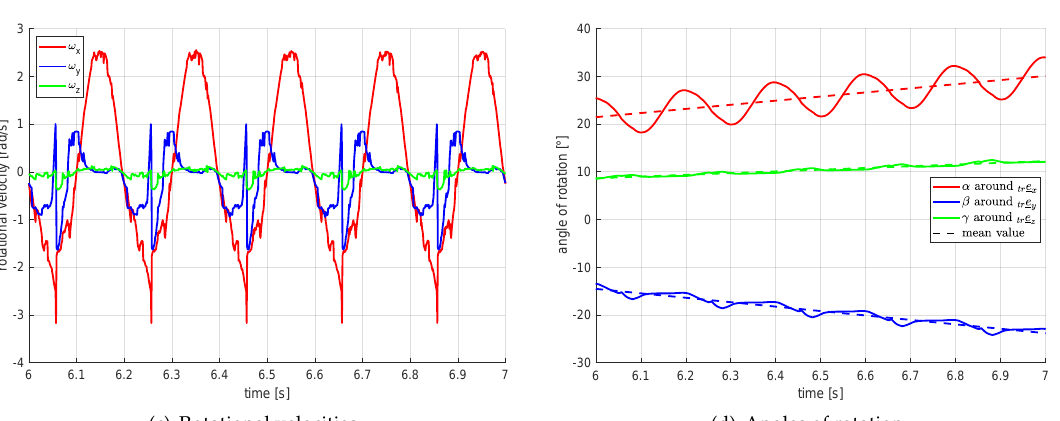
(d) Angles of rotation